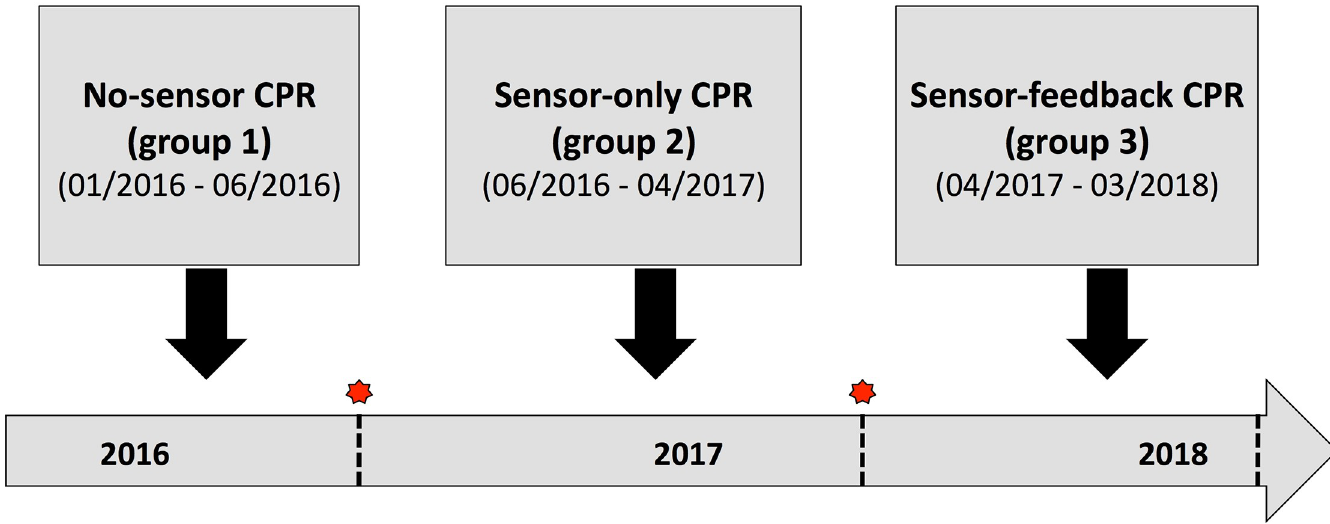
Fig 2. Graphic illustration of the study